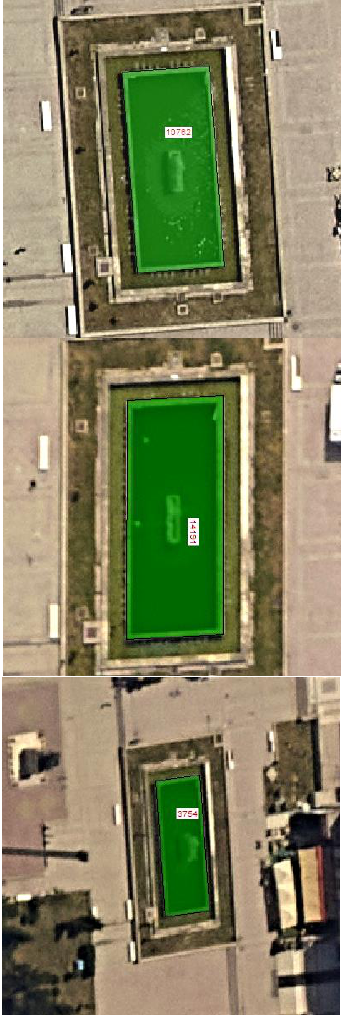
Figure 9. Up the target area measured in the nadir_3410 im- age, in the middle the higher resolution on image left_2955 and below the image right_3087 with the lowest resolution.